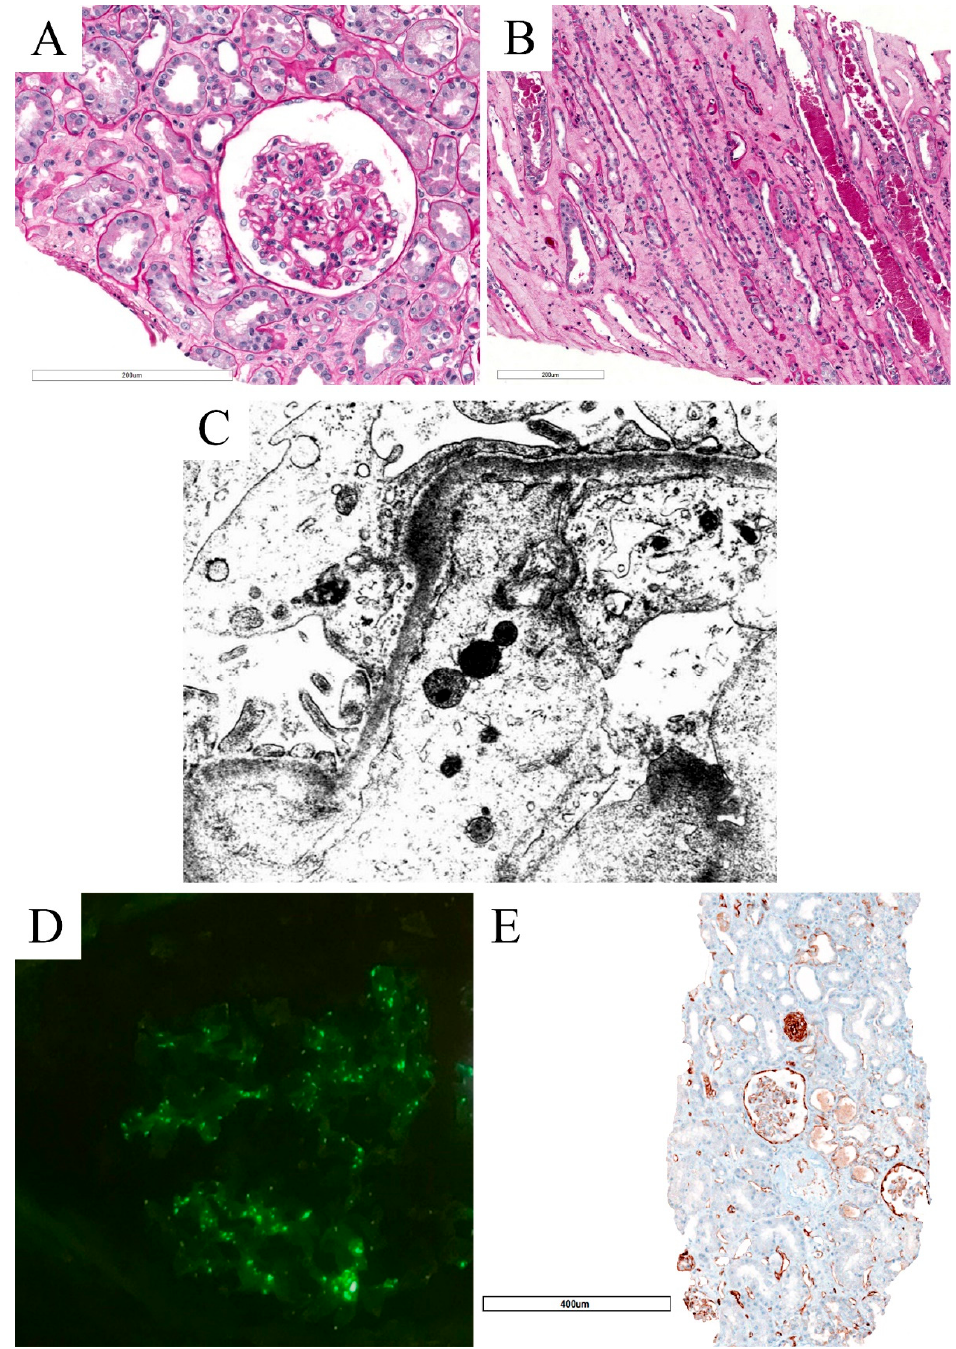
Figure 2. Histomorphological, IF, and ultrastructural features of Case 2. PAS stain ( A , B ) showing segmental wrinkling of glomerular basement membranes ( A ) and details of ATN (flattened epithelial cells and denudation of tubular basement membrane with necrotic material in lumen; ( B ). EM analysis showed segmental foot process effacement and confirmed the collapsed glomerular basement membrane with mild subendothelial space widening and loss of endothelial cell fenestrae ( C ), whereas IF showed a mild and unspecific positivity for C3 ( D ). Cav1 immunohistochemistry showed diffuse positivity both in peritubular capillaries and glomeruli ( E ).